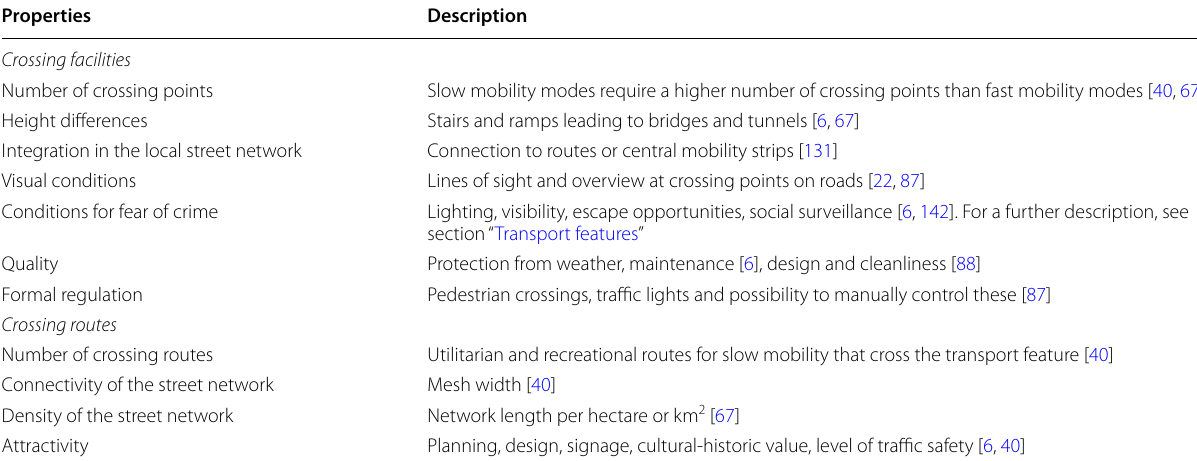
Table 2 Properties of crossing facilities and routes that determine barrier effects